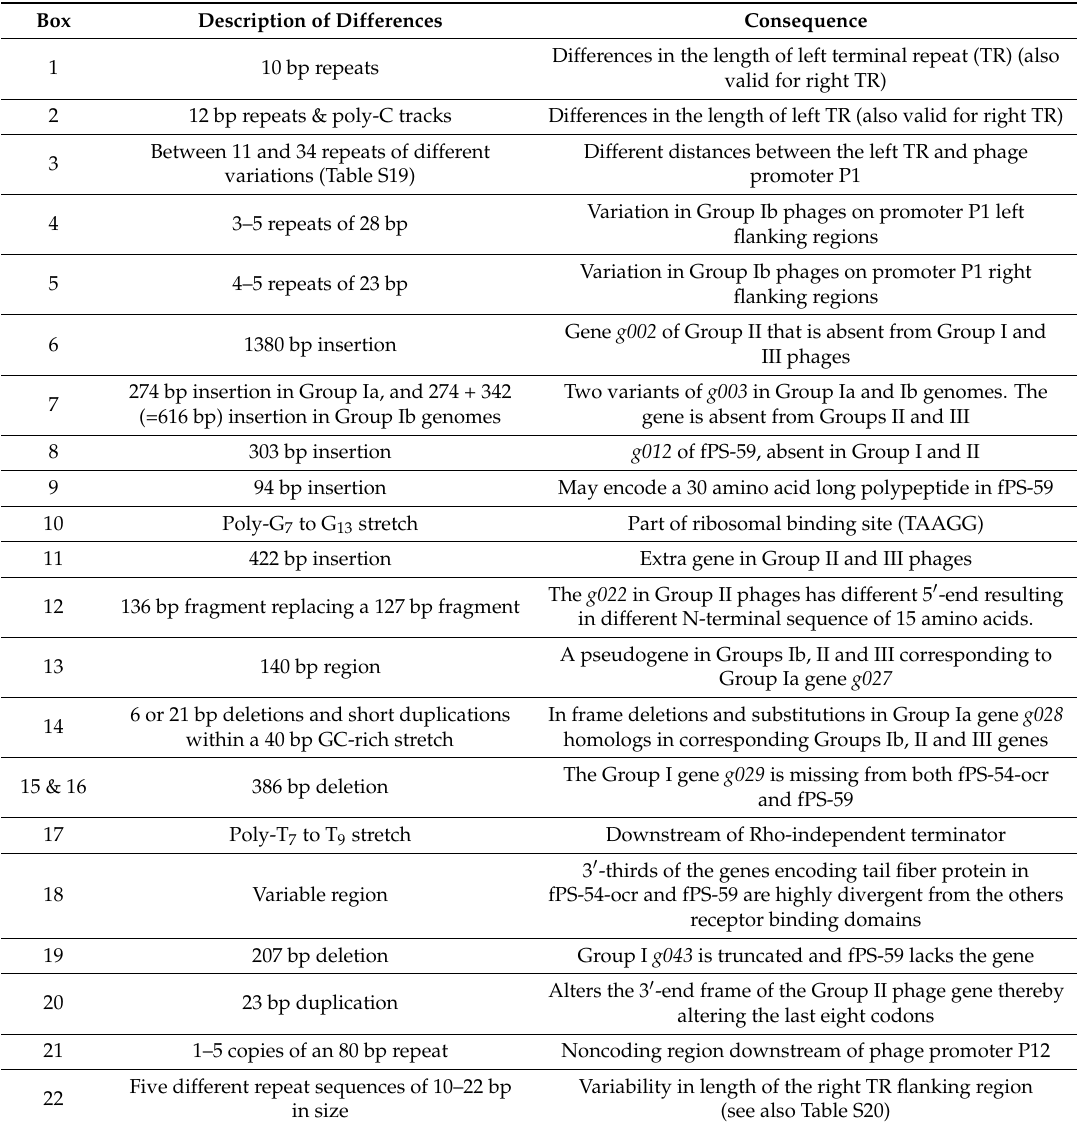
Table 4. Microevolution of the fPS-phages. Summary of the genome differences between fPS-phages. The Box numbers refer to Figure S3, where the differences are indicated by numbered